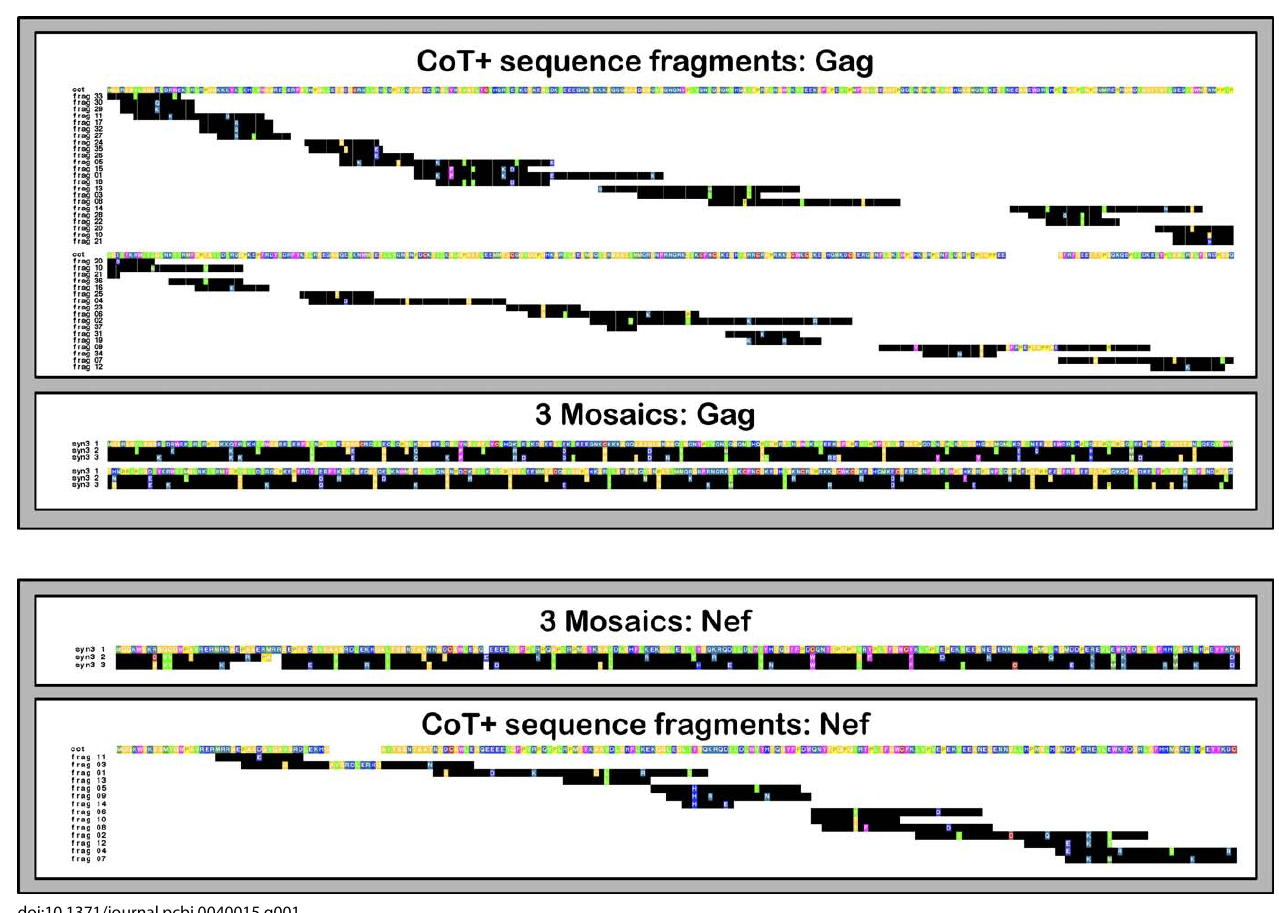
Figure 1. Relative Locations and Sequence Identities of Potential Vaccine Antigens The COT þ candidate vaccine sets represent one full-length COT protein plus numerous discrete sequence fragments located in various positions relative to the intact Gag protein; mosaics are full-length ‘‘ native-like ’’ proteins. For the COT þ sequence sets, the sequence on the top line is the COT sequence; additional peptide fragments are numbered by addition order, and plotted by location from N-terminus to C-terminus. Gag sequences are presented in two parts. For the mosaic sets, the sequence in the top line was arbitrarily chosen from the set, as the mosaics are designed as a combination of strains. For all sequence sets, amino acid residues identical to those in the top line sequence are shown with a black background; differences from the first sequence are shown in color, with different colors representing different amino acid classes; white space is used to represent gaps. The COT þ antigen sequences [1] were generously provided by J. I.